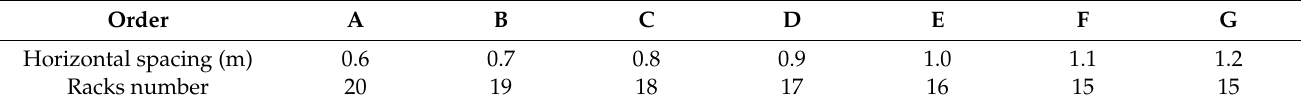
Table 3. Parameters of cultivation racks in the horizontal spacing investigation.